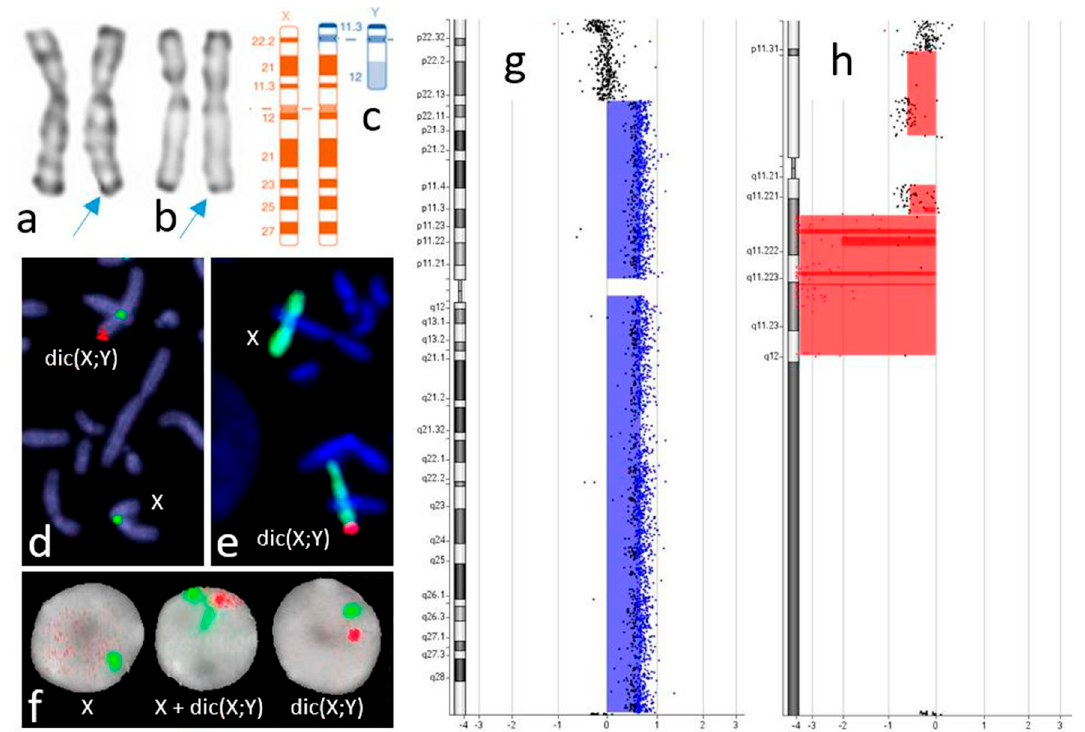
Figure 1. Cytogenetic analysis: the X and psu dic(X;Y) chromosomes using GTG ( a ) and RHG ( b ) banding, with the arrow showing the dic(X;Y); ( c ) ideograms for the X, dic(X;Y) and Y chromosomes; fluorescent in situ hybridization using SRY and X chromosome centromeric probes ( d ) and X and Y chromosome painting probes ( e ) on metaphase and ( f ) X and Y centromeric probes on nuclei; CMA results for the X ( g ) and Y ( h ) chromosomes, using a normal male reference.